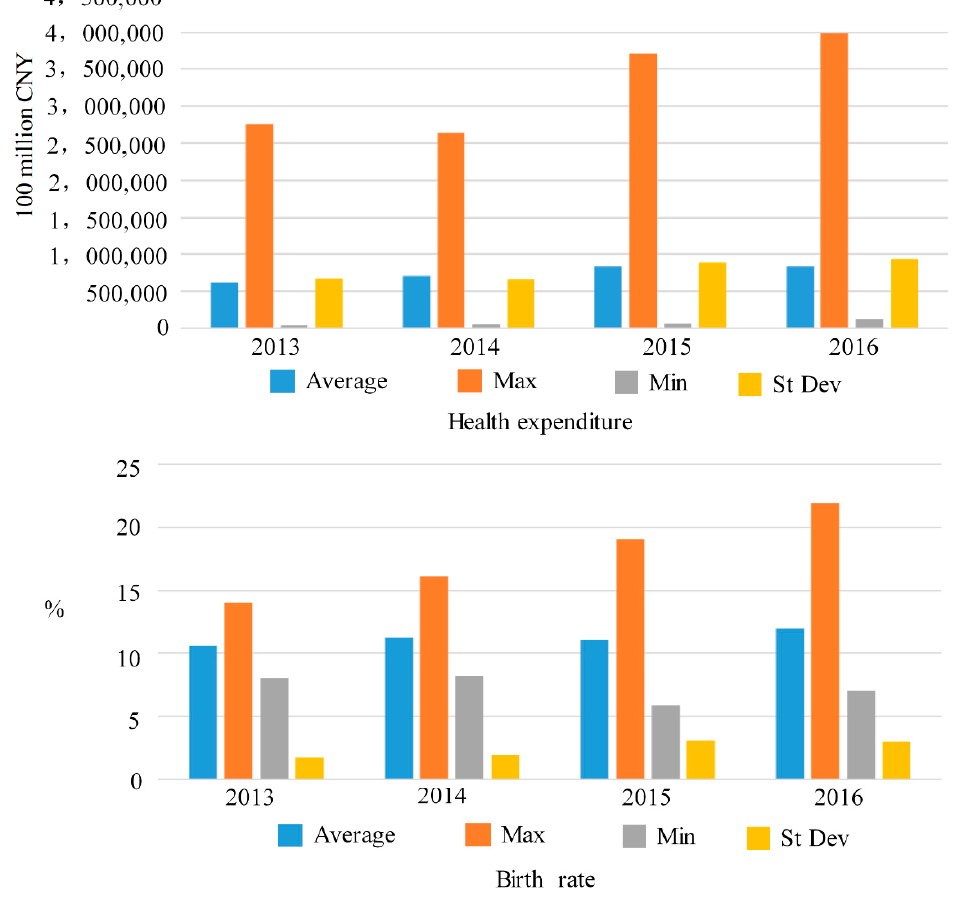
Figure 4. Health expenditures and birth rates from 2013–2016.